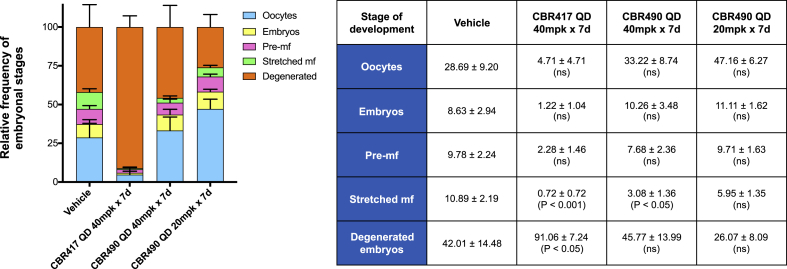
Embryograms of femaleB. pahangishow that CBR417 and CBR490 affect late stages of developing mf.Both CBR417 and CBR490 (40 mg/kg QD for 7 days) significantly reduced the number of later-staged mf. Female worms recovered from jirds treated with CBR417 also had significantly more degenerated embryos in their ovaries. Embryonic stages (oocytes, embryos, pre-mf, stretched mf and degenerated embryos) per female adult worm were removed from jirds infected with B. pahangi and counted from the ovaries and uteri of individual worms. Results are shown as mean relative frequencies of embryonic stages ± SEM